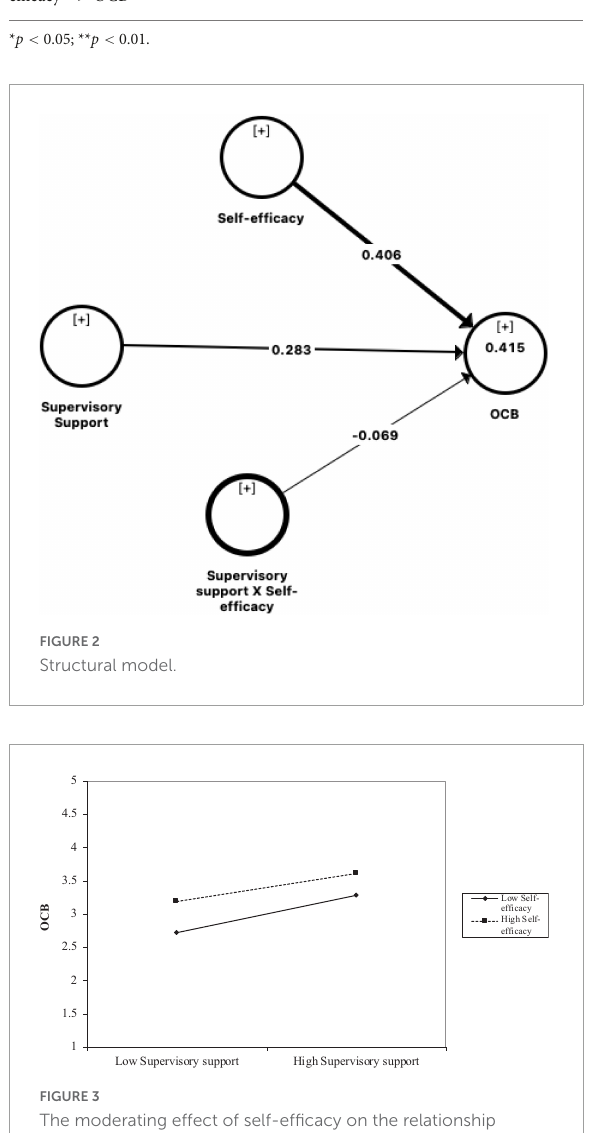
FIGURE3 The moderating effect of self-efficacy on the relationship between supervisory support and